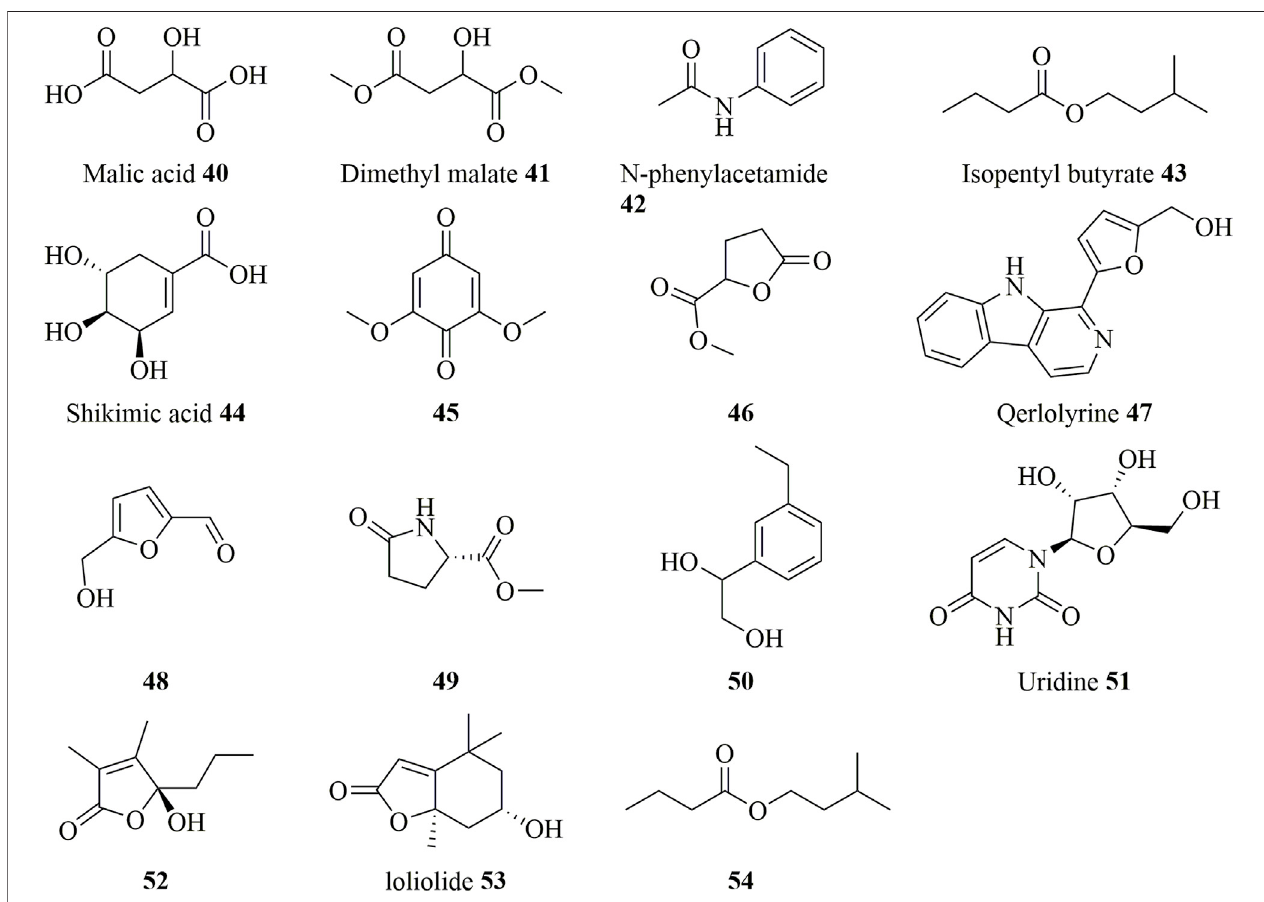
FIGURE 7 | Structure of other compounds ( 40 – 54 ) in D. huoshanense